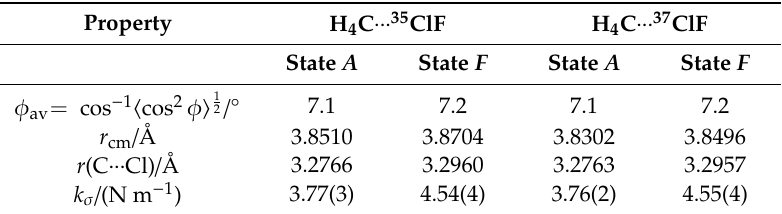
Table 3. Distances r cm and r (C ··· Cl), oscillation amplitudes φ av = cos − 1 (cid:104) cos 2 φ (cid:105) 1 2 , and intermolecular stretching force constants k σ determined for H 4 C ··· ClF a .